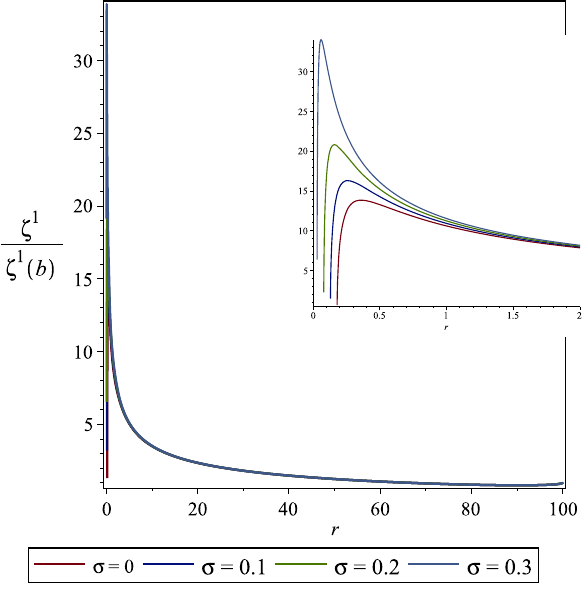
Fig. 5 Radial components of geodesic deviation for a Kiselev BH surrounded by radiation with IC1 for different values of the radiation parameter with M = 1, q = 0 . 6 and b =